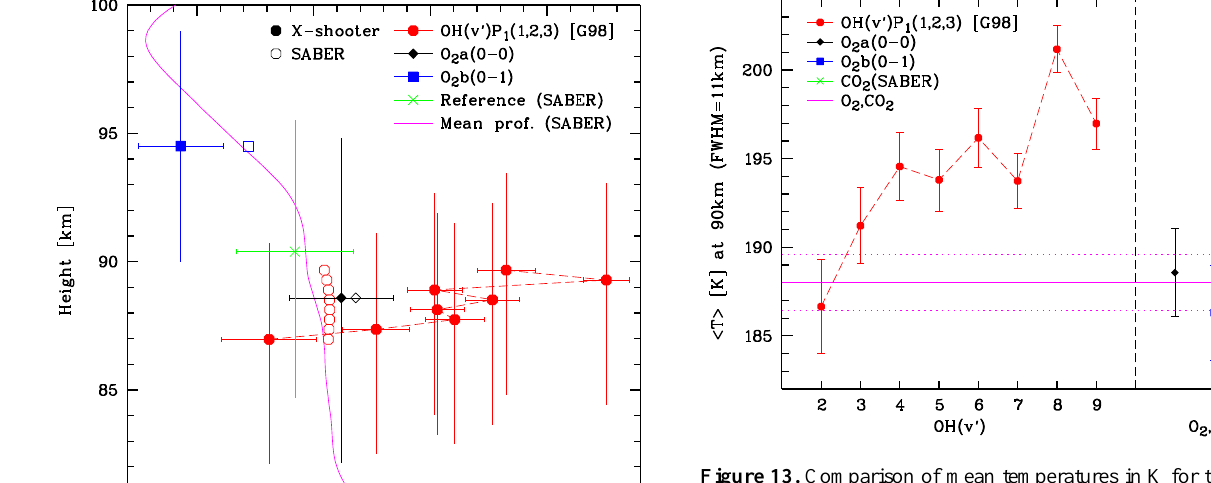
Figure 13. Comparison of mean temperatures in K for the O 2 a (0- 0)-based reference profile and the full X-shooter sample. The v (cid:48) - dependent OH T rot (circles) are based on measurements of the first three P 1 lines and HITRAN-based molecular parameters (Goldman et al., 1998). The systematic errors related to the latter are not in- cluded in the plotted error bars. HITRAN-based molecular param- eters were also used for the derivation of the T rot from O 2 a (0-0) (diamond) and O 2 b (0-1) (square). The cross shows the CO 2 -based SABER T kin for the reference profile and the full X-shooter sam- ple. The mean and the uncertainties derived from the three non-OH temperatures are marked by horizontal